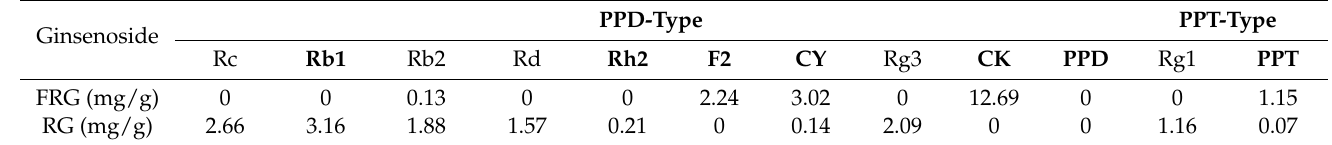
Table 1. The contents of ginsenoside between fermented red ginseng (FRG) or red ginseng (RG). PPD-Type Ginsenoside